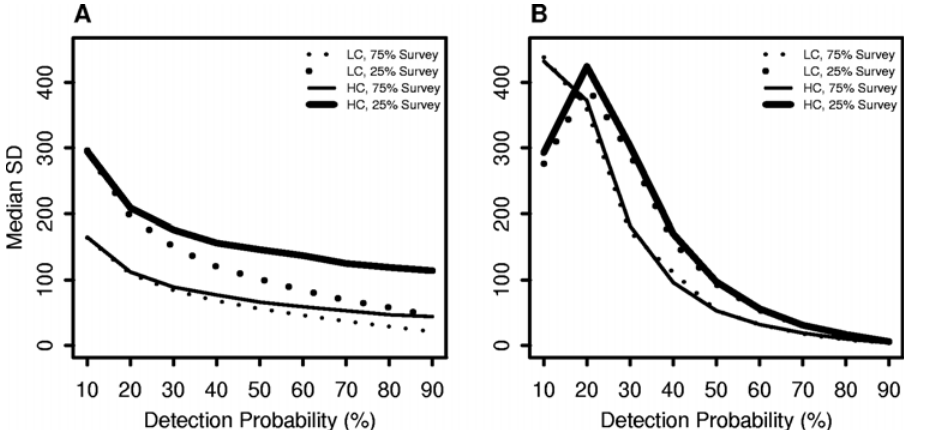
Figure 3. Median standard deviation of population estimates. The figures show the changes in median standard deviation (SD) relative to detection probability for the low (LC) and high clustered (HC) populations at survey proportions of 25% and 75% for the double observer and double sampling methods (Panels A and B, respectively). Median standard deviation for the double observer method is larger than for the double sampling method at low detection probabilities but is very small at high detection probabilities.